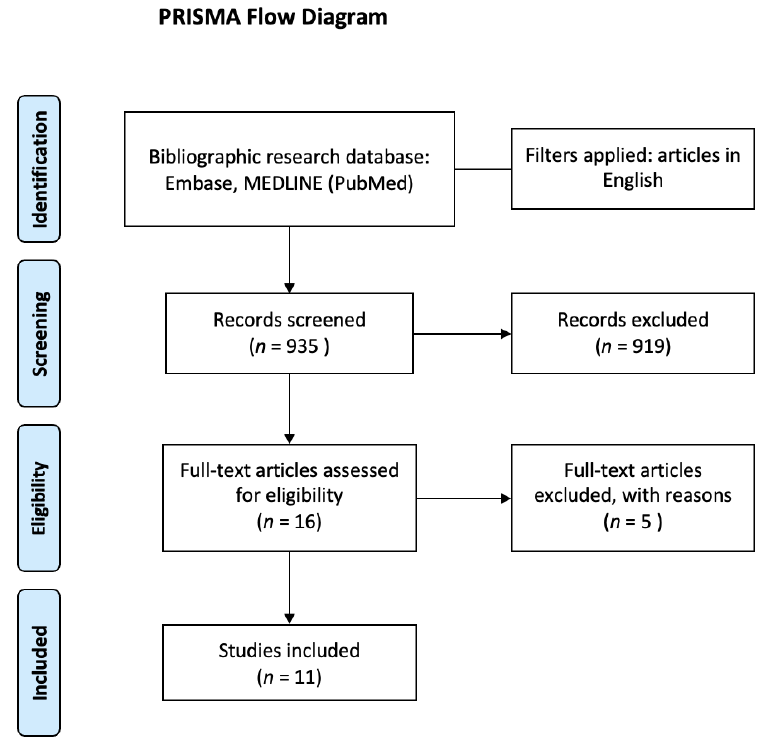
Figure 1. PRISMA flow diagram. Table 1. Demographic and Clinical Characteristics of